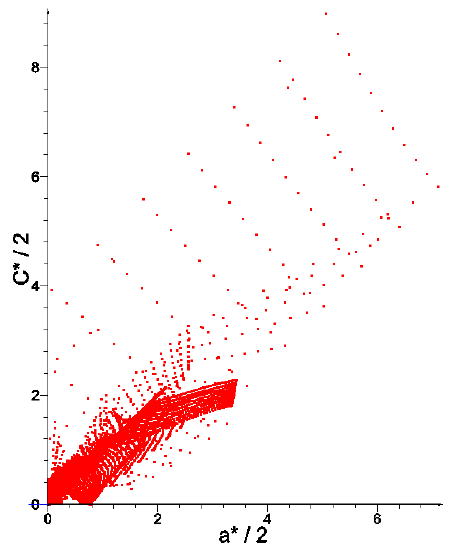
Figure 7. Distribution of optimal pairs of points ( a */2, c */2).